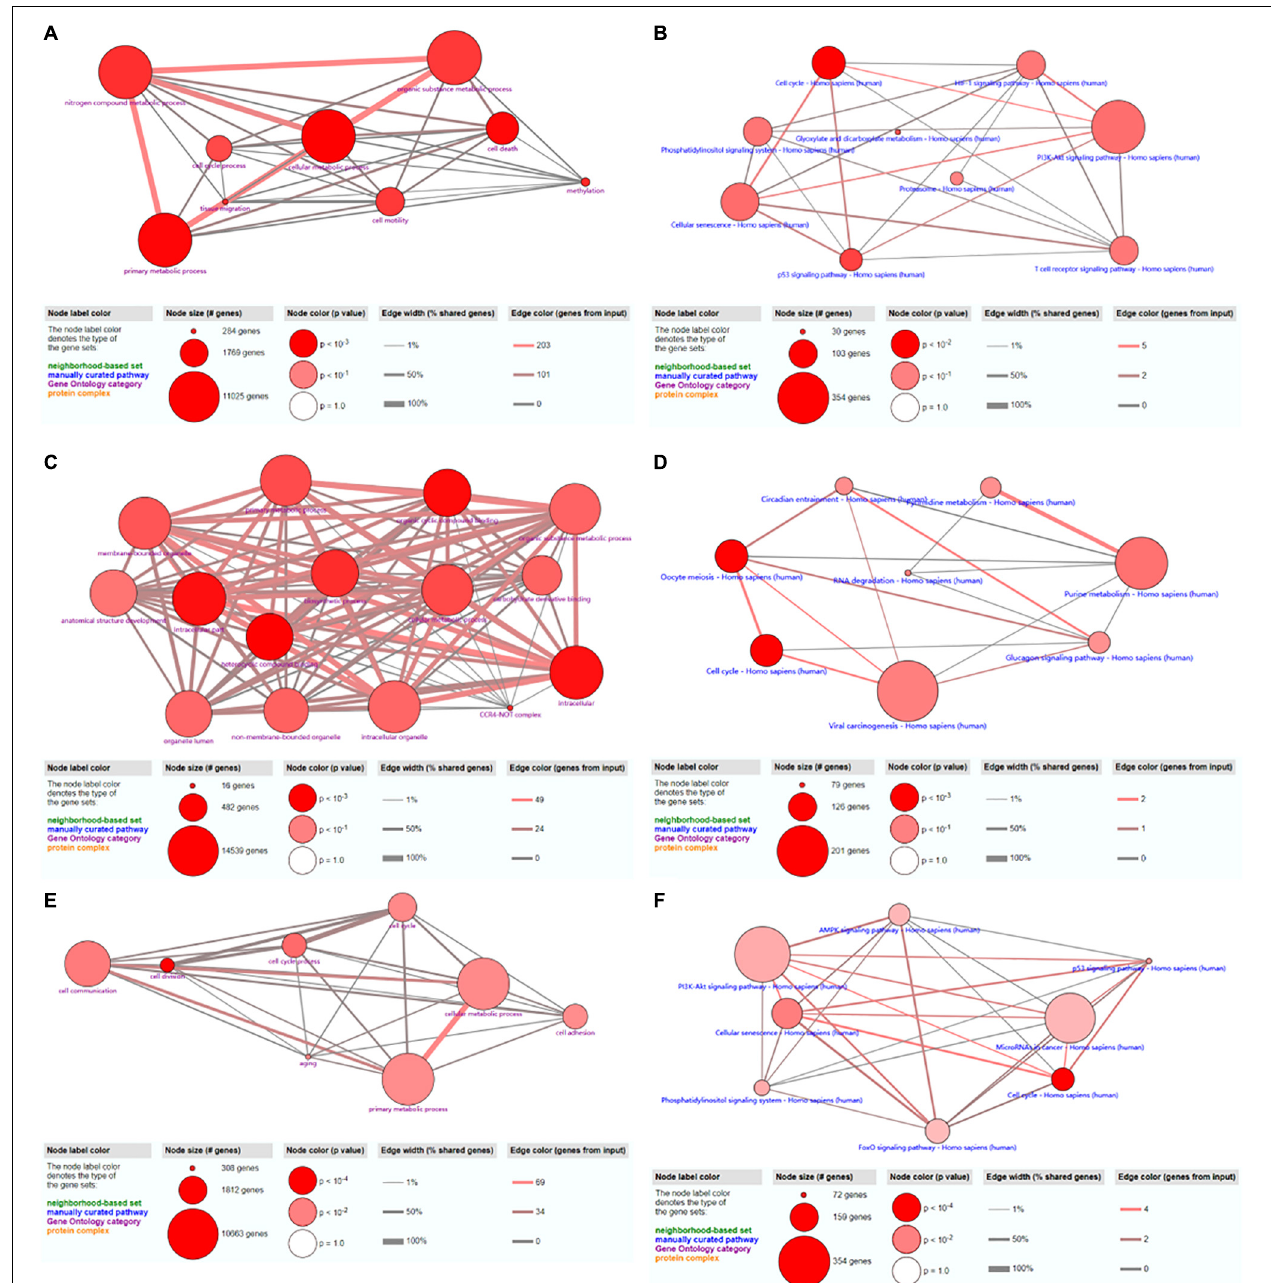
FIGURE 7 | GO and KEGG analyses of hsa_circ_0024353 (A,B) , hsa_circ_0031408 (C,D) , and hsa_circ_0085494 (E,F)